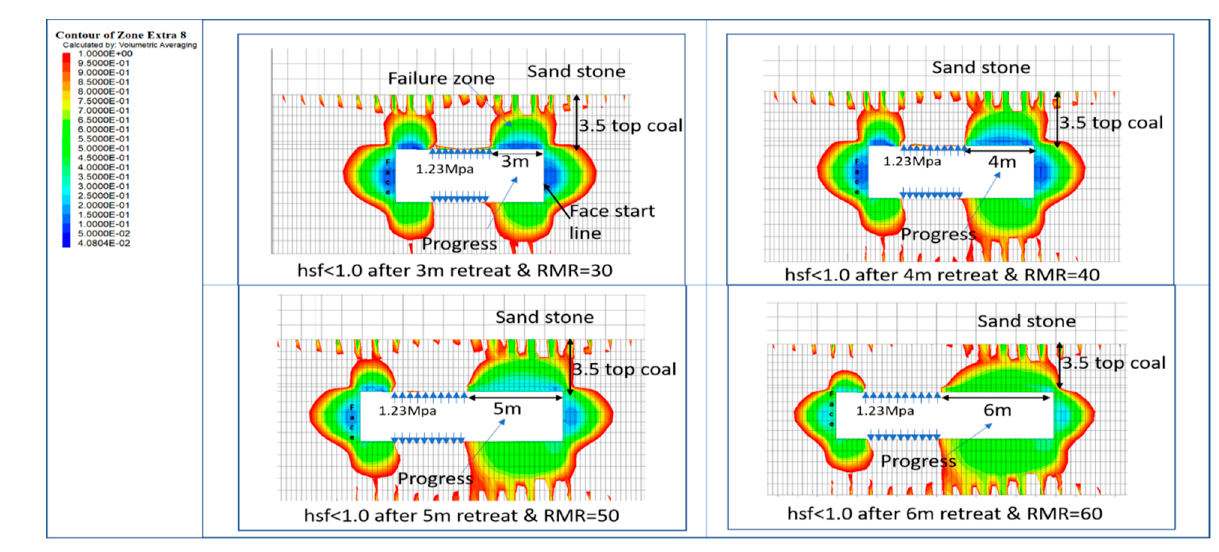
Figure 3. Modeling for different RMR values.